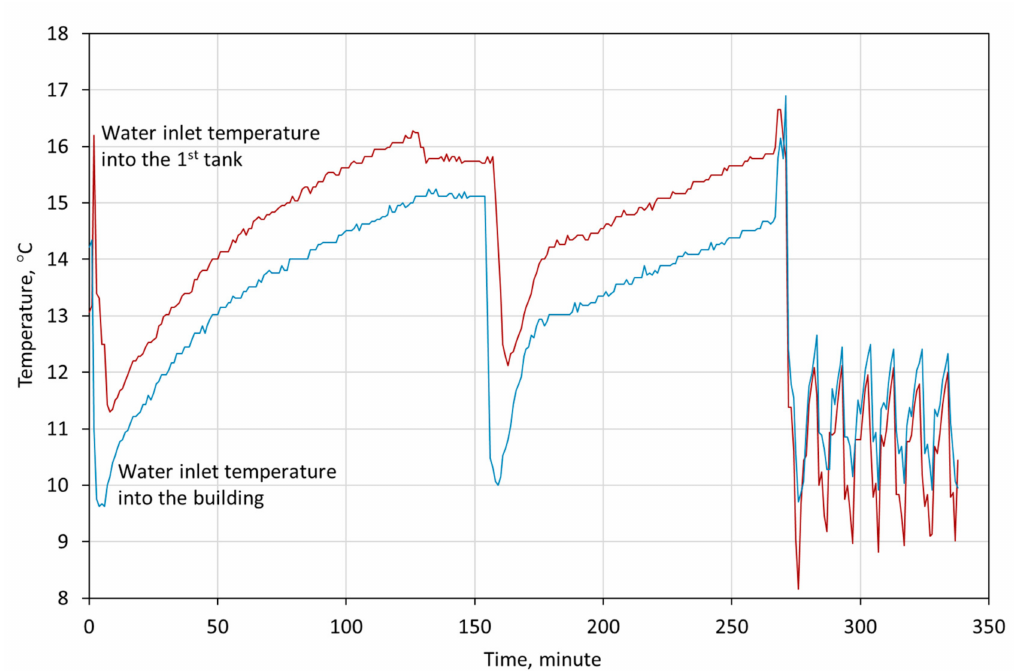
Figure 3. The results of measuring the temperature of the water entering and leaving the tanks during their discharge for the system operating in the cascade